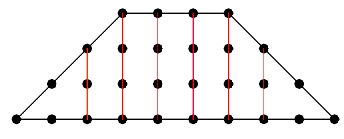
Figure 1 . A toric diagram and one of its partial resolution, and we also write down a gauge theory